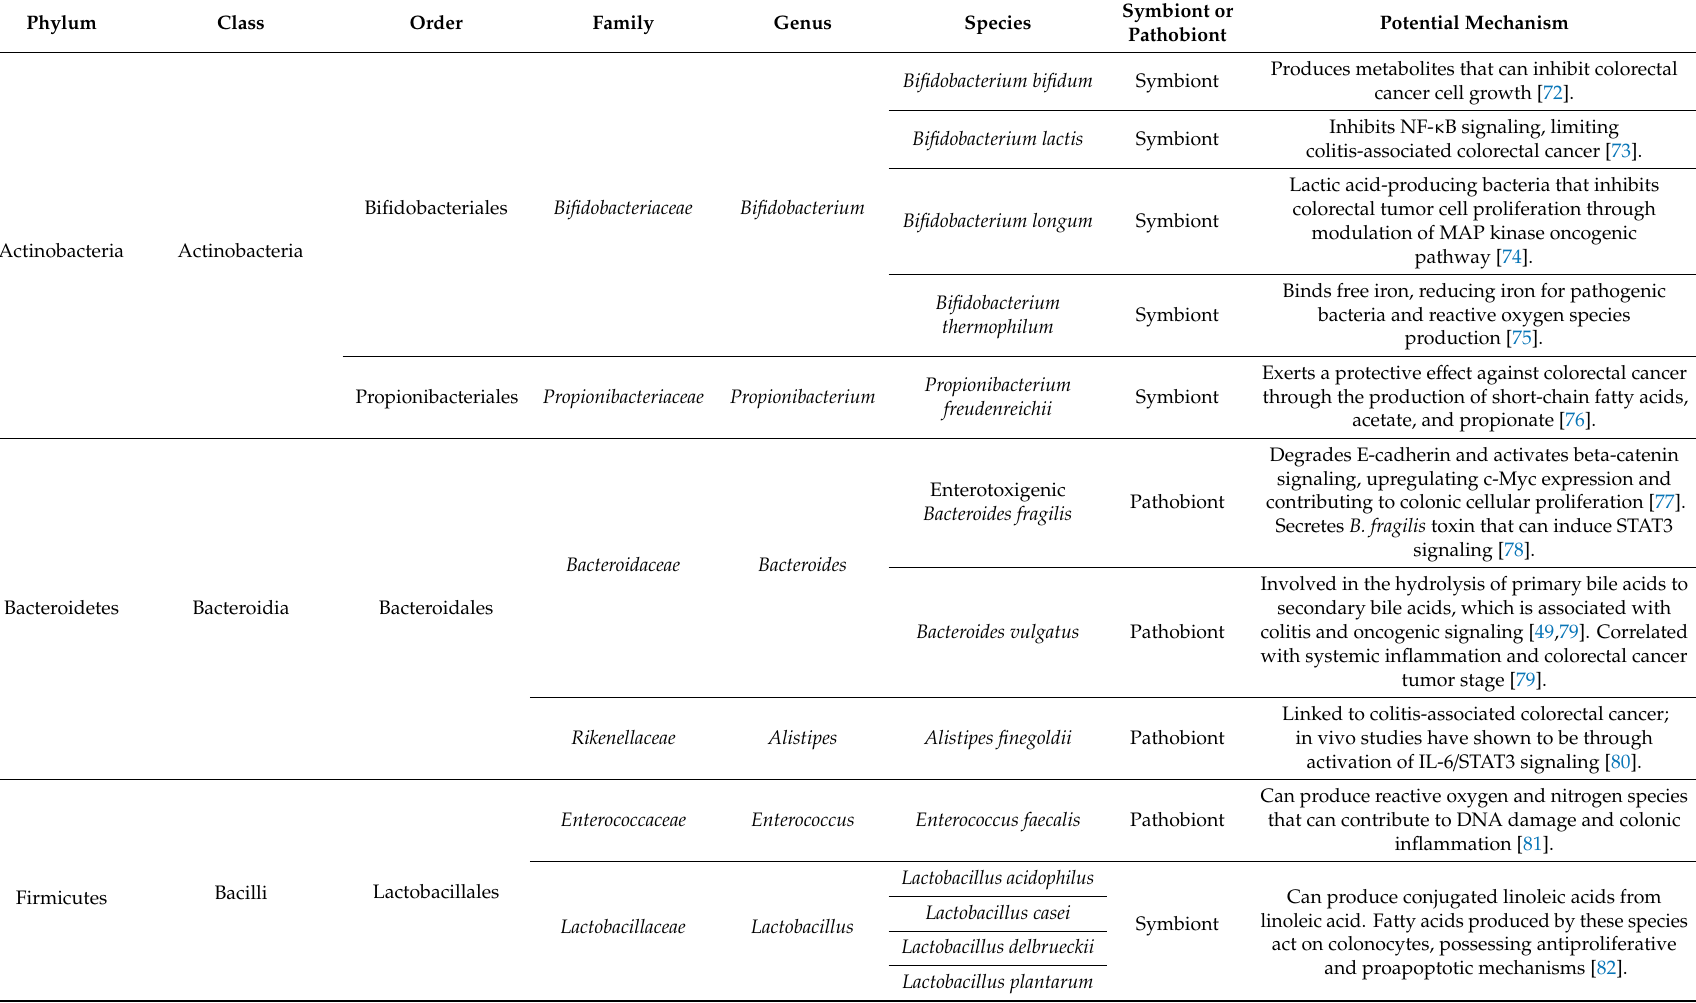
Table 1. Potential mechanisms of symbionts and pathobionts in colorectal cancer